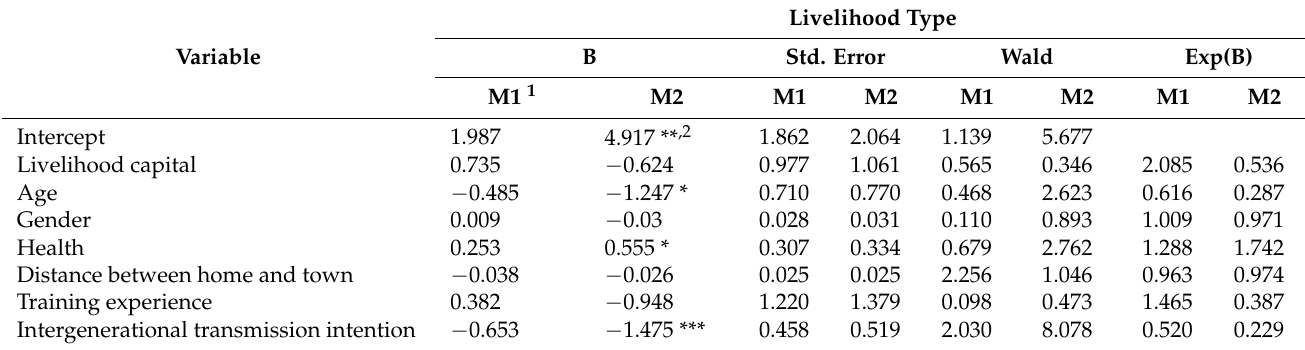
Table 6. Results of the moderating effect of sense of responsibility (=0).